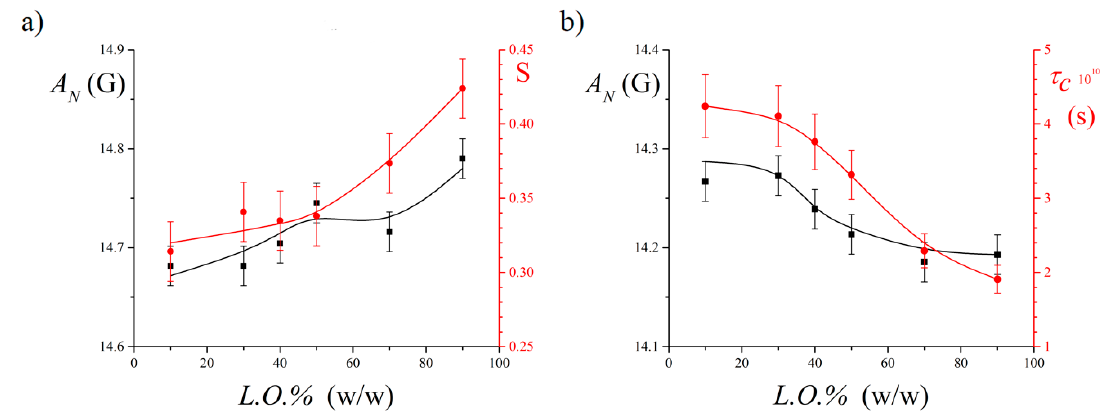
Figure 5. Dependence on oil content L.O.% of the EPR spectroscopic parameters of 5-DSA ( a ) and 16-DSA ( b ) in wa- ter/L.O./(Tween80 + Span80) emulsions at 25 °C. For both spin-probes, the hyperfine coupling constant A N is reported (on the left-hand side ordinate). The right-hand side ordinate reports the order parameter, S , and the correlation time, τ c , for 5-DSA and 16-DSA, respectively. The total surfactant amount was fixed to 4% in weight with respect to the total sample amount and surfactant compositions was α Span80 = 0.4 in all samples.